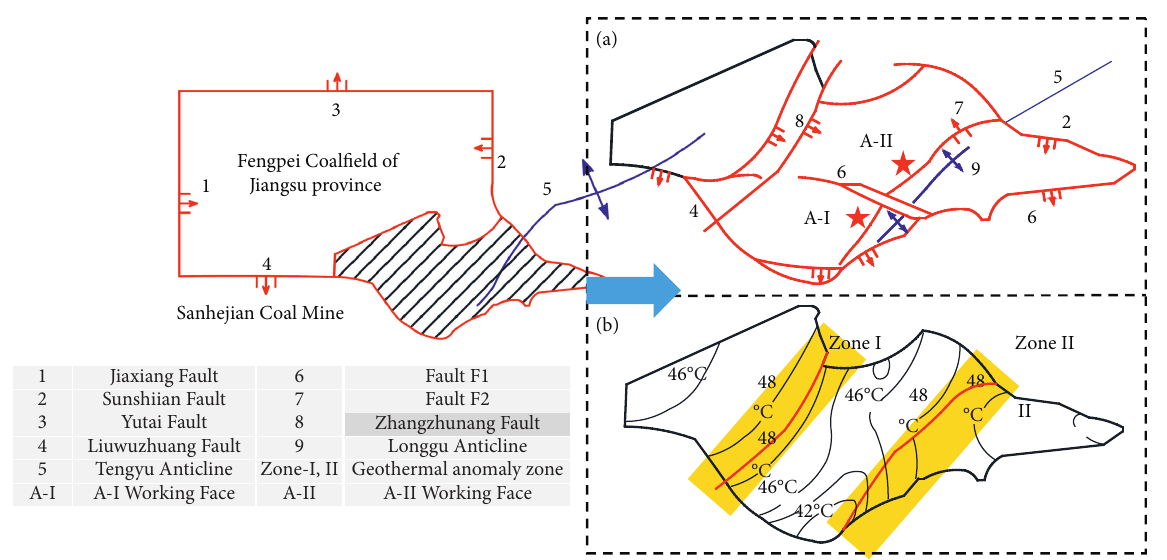
Figure 1: Sanhejian Coal Mine in China: (a) geological structure and (b) geothermal temperature isogram at the depth of − 980m. Table 2: Impermeability and thermal conductivity of strata in Sanhejian Coal Mine [34, 35]. Era